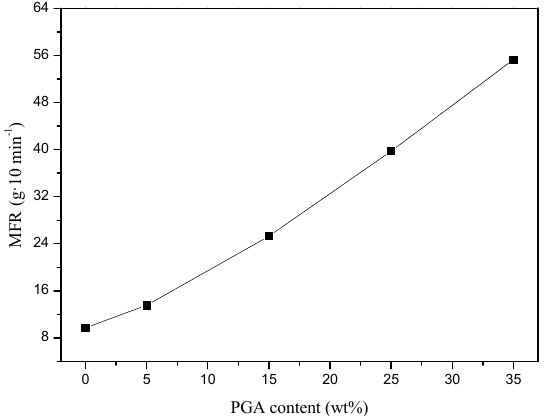
Figure 7. Influence of PGA content on MFR of PETG/PGA samples.